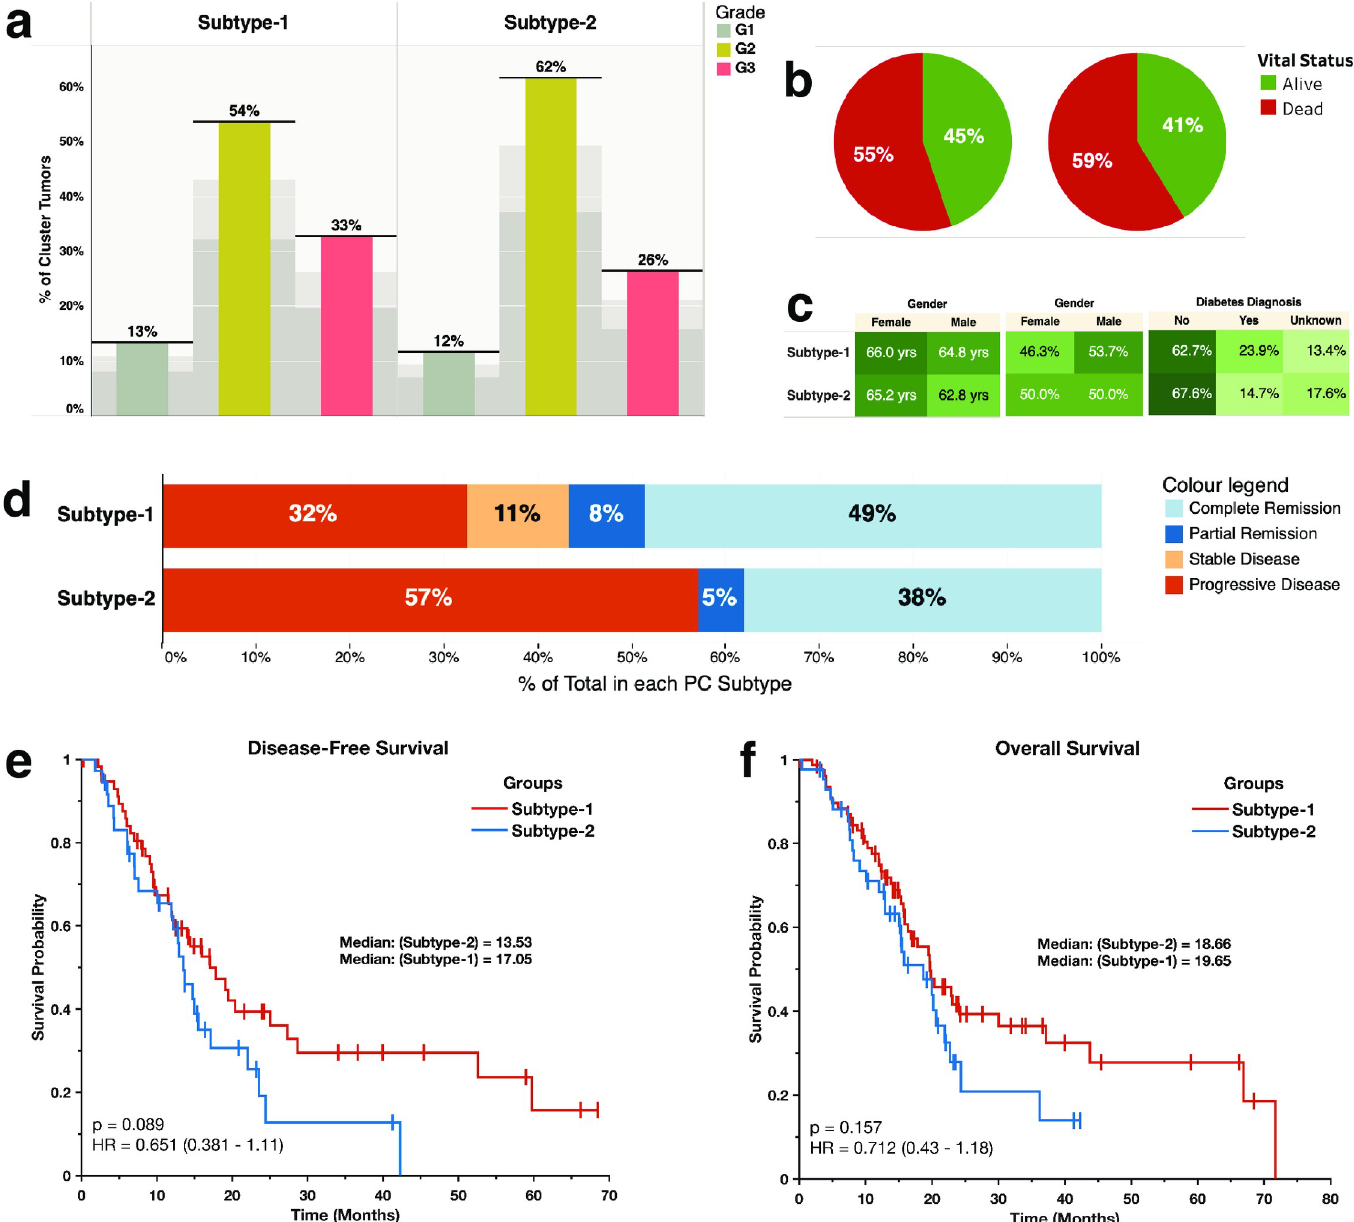
Fig 2. (a) Distribution of tumour grades across the proteomic subtypes: Showing the percentage of the total count of the number of tumours for each grade of tumour broken down by proteomic subtype. (b) Pie chart showing the vital statistics after the first course of treatment across the two disease subtypes. (c) Highlight tables showing the distribution of, from left to right: The study participants’ age, gender, and the diabetes diagnosis. (d) The clinical outcomes after the first course of treatment across the disease subtypes. (e) Kaplan-Meier curve of the disease-free survival months of patients afflicted by each pancreatic cancer subtype ( f) Kaplan-Meier curve of the overall survival months of patients afflicted by each pancreatic cancer